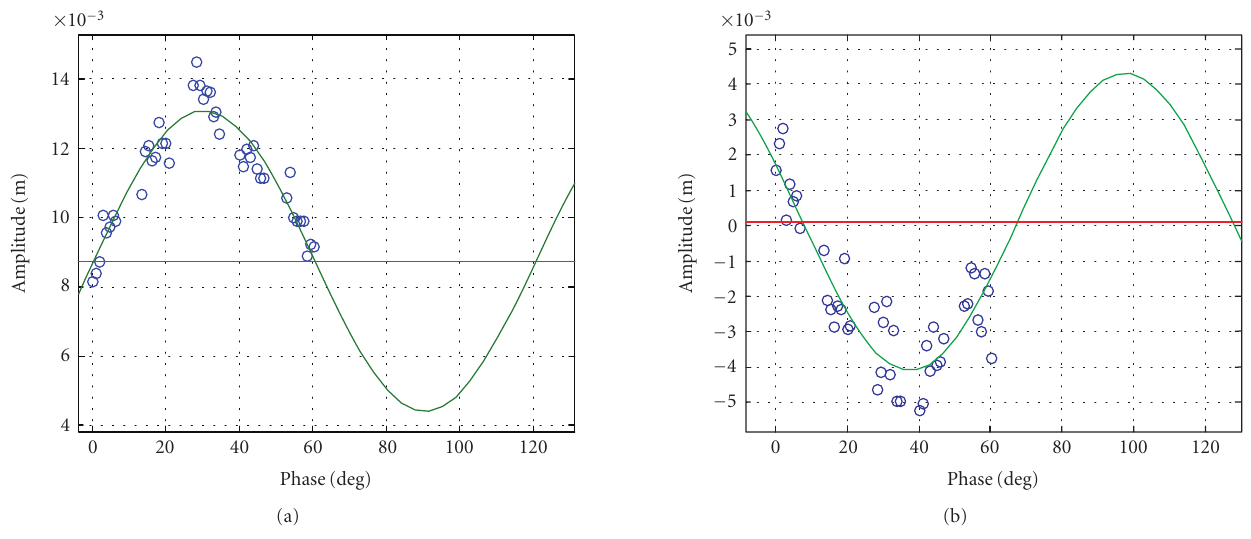
Figure 13: 3EO case normal and tangential visualised displacements and curve-fits.